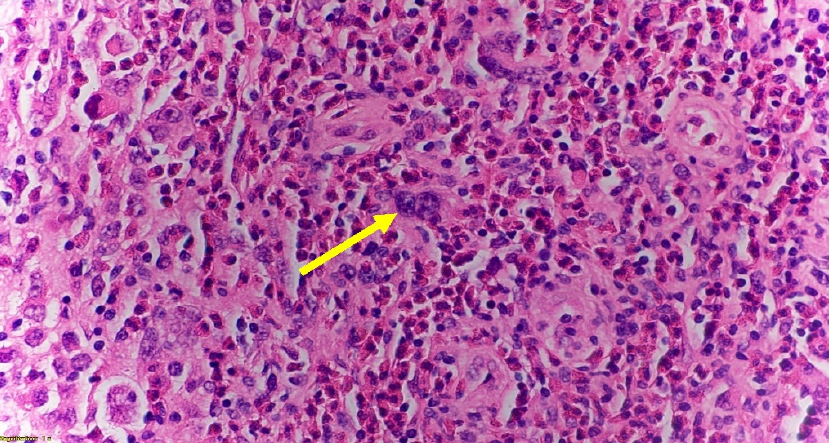
Figure 3. Magnified (60×) image of lymph node showing large structure with polylobular nuclei of a lacunar cell which are commonly seen in nodular sclerosing classical Hodgkin lymphoma NS-CHL (yellow arrow).